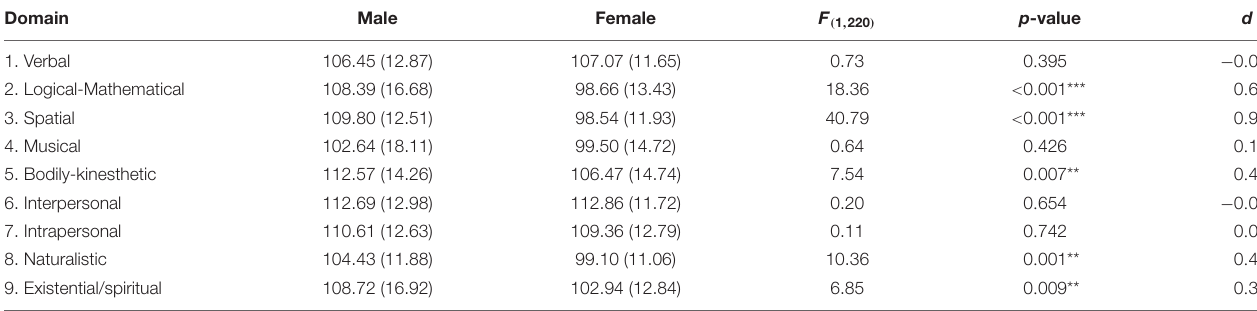
TABLE 4 | Gender differences on self-estimated multiple intelligences. Domain